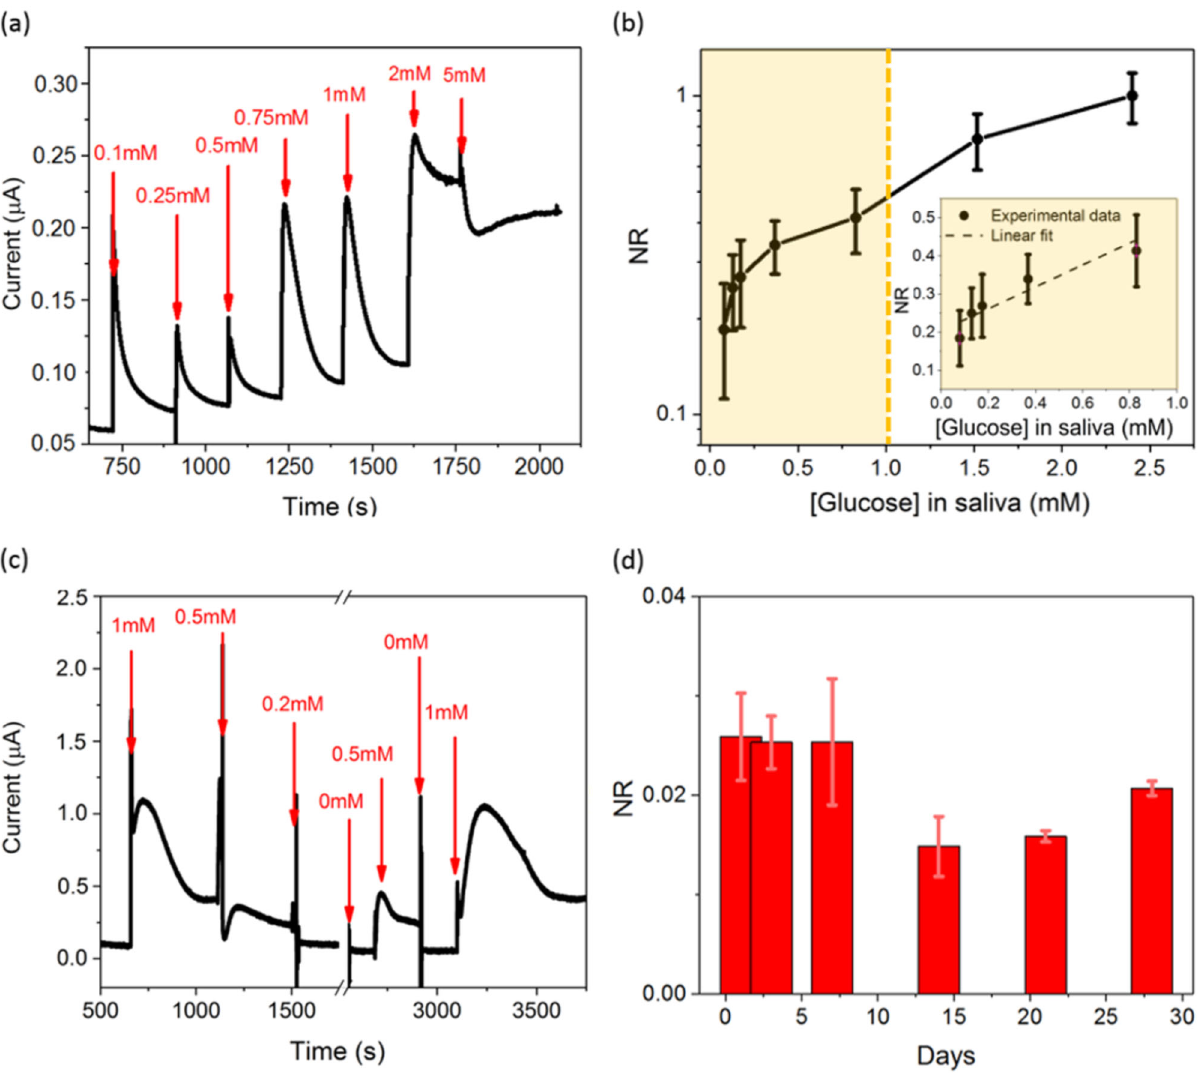
Fig. 4 a Current-time characteristics of the sensor in response to different concentrations of glucose successively added into saliva. The arrows highlight the times at which glucose was introduced into the measurement solution. The applied voltage is 0.25 V versus PEDOT:PSS reference electrode. b NR of the sensor to glucose in saliva. The highlighted area represents the range for physiologically relevant glucose concentrations. The inset is the calibration curve in linear scale magni fi ed for low glucose concentrations with the dashed lines representing the linear fi t. The error bars are extracted from the read-outs of 3 different devices. c Real-time current changes when glucose is added into or taken from the measurement solution. To decrease the concentration of glucose, a pre-determined volume of the solution is replaced with the same amount of PBS. d The performance of the sensors that have been stored for up to one month after fabrication. The glucose concentration in the measurement solution is 1